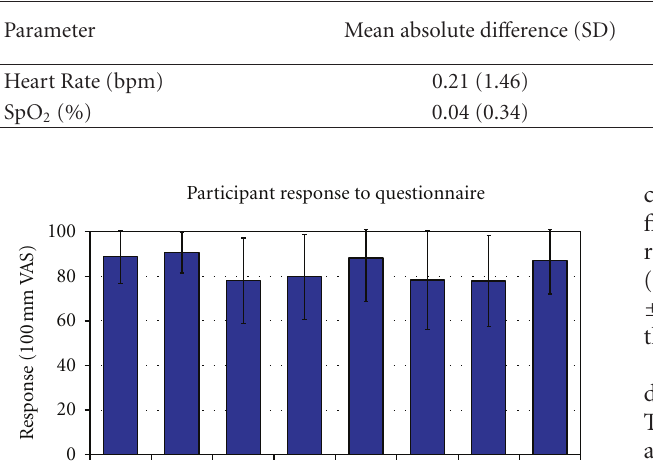
remote pulse oximeter was uncomfortable ( n = 4), and audio or video quality was “jumpy” ( n =